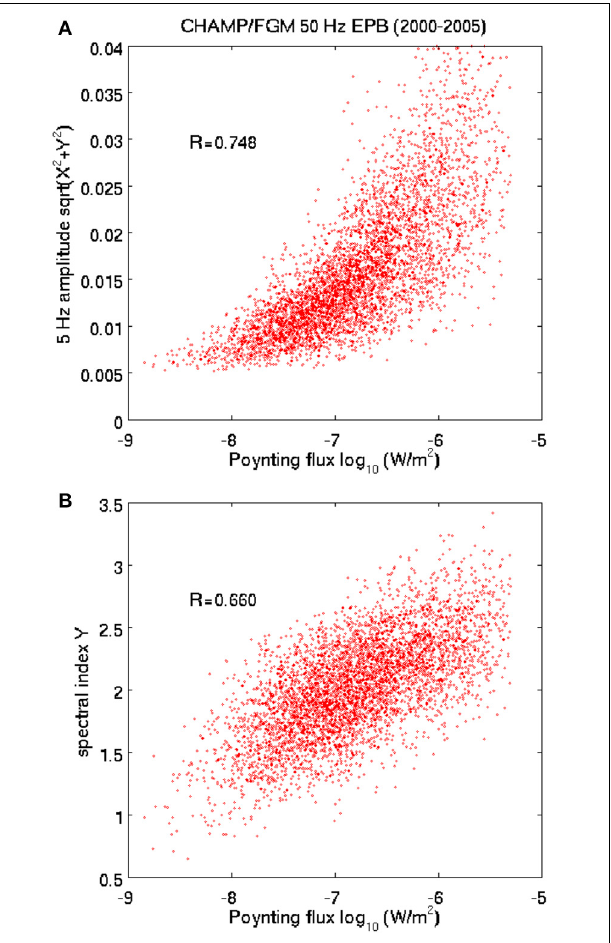
FIGURE 6 | Characteristics of the Alfvén wave Poynting flux. (A) The Poynting flux increases monotonically with the signal amplitude, but in a highly non-linear way. (B) Relation between the spectral index of the Alfvénic signal and the log of the Poynting flux. Steep spectra are related with higher energy